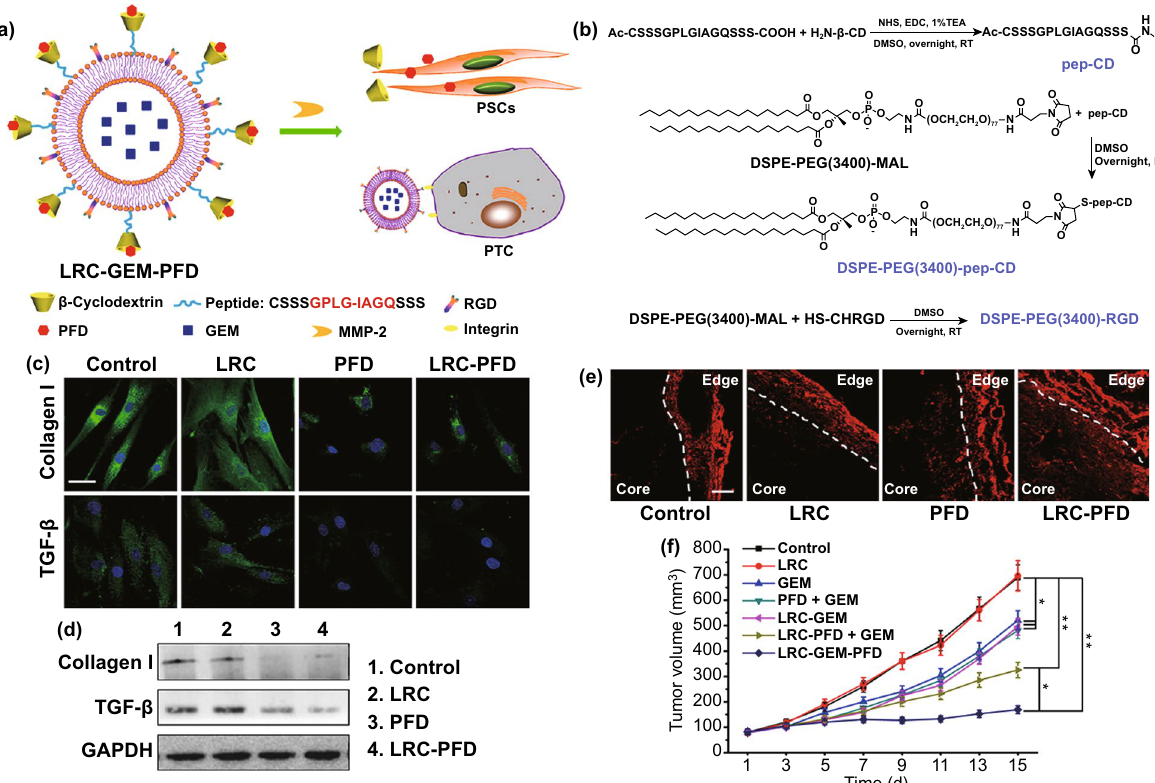
Fig. 7 a The PFD inserts into the hydrophobic chamber of β-CD, and the GEM was encapsulated in the liposome. If the LRC-GEM-PFD is cleaved by MMP-2, the PFD part will regulate the PSCs, and the GEM containing liposome will recognize and kill the PTCs. b Synthesis of pep-CD, DSPE-PEG(3400)-pep-CD, and DSPE-PEG(3400)-RGD. c The immunofluorescence staining of collagen I and TGF-β. Blue: HOE- CHST, green: FITC-labeled collagen I or TGF-β. The scale bar: 50 μm. d The Western blot analysis of the collagen I and TGF-β in the condi- tioned medium of PSCs. e Penetration of Rhd into pancreatic tumor (Panc-1 and PSCs coimplanted) tissues after intravenous injection of differ- ent PFD formulations. Red: Rhd. The scale bar is 100 μm. f Tumor growth curves of PSCs/Panc-1 pancreatic tumors in mice treated by different GEM formulations. GEM dose: 20 mg/kg. Data were presented as mean ± standard deviation *p < 0.05, **p < 0.01 vs control. Reproduced with permission from Ref.